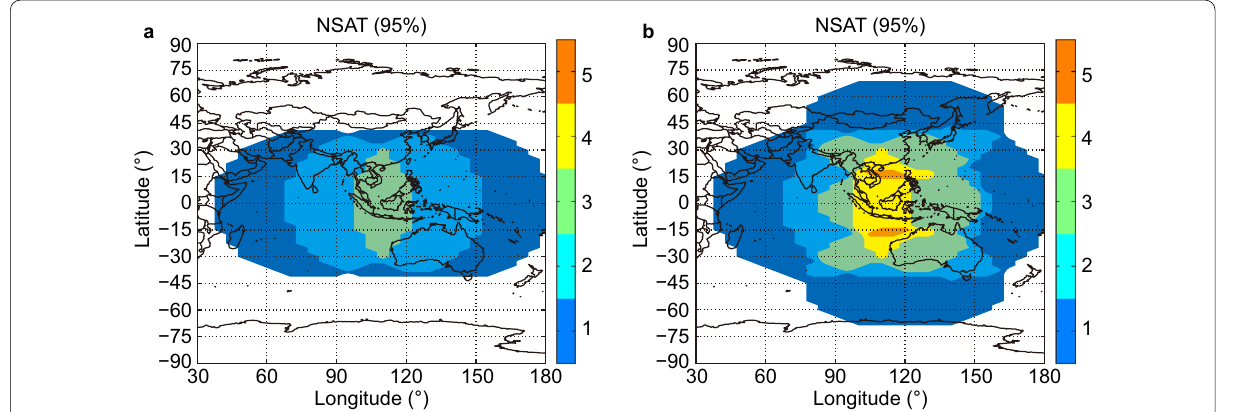
Fig. 1 a 3 visible GEO sats with the elevation cut-off angle of 40°. b 3 GEO